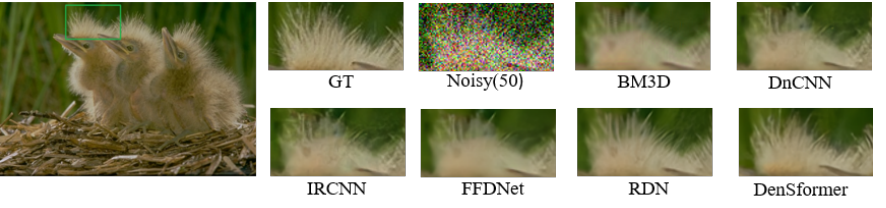
Figure 4. Color image denoising results with noise level σ =